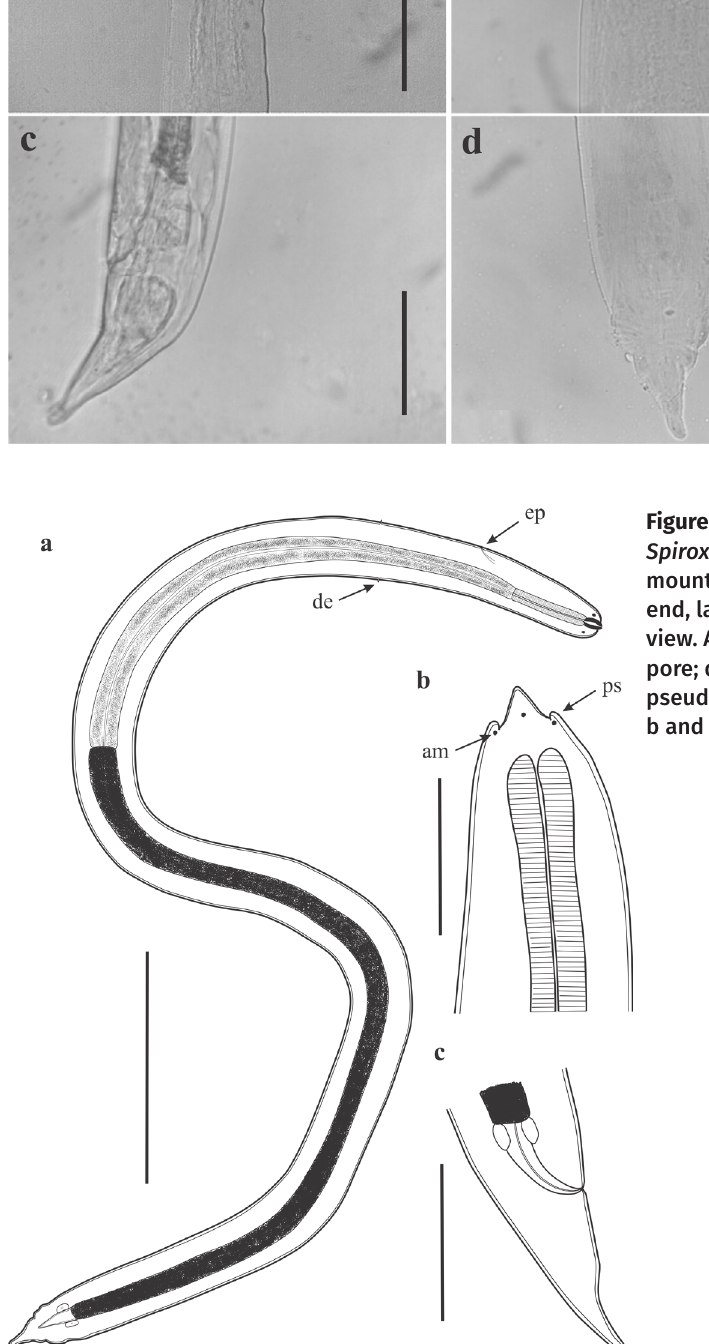
Figure 2. Photomicrographs of the Spiroxys sp. (larvae stage). (a) anterior end of body, lateral view; (b) anterior end of body (note deirids); (c) tail, lateral view; (d) tail, ventral view. Abbreviations: ps = pseudolabia; de = deirids. All scale bars = 50